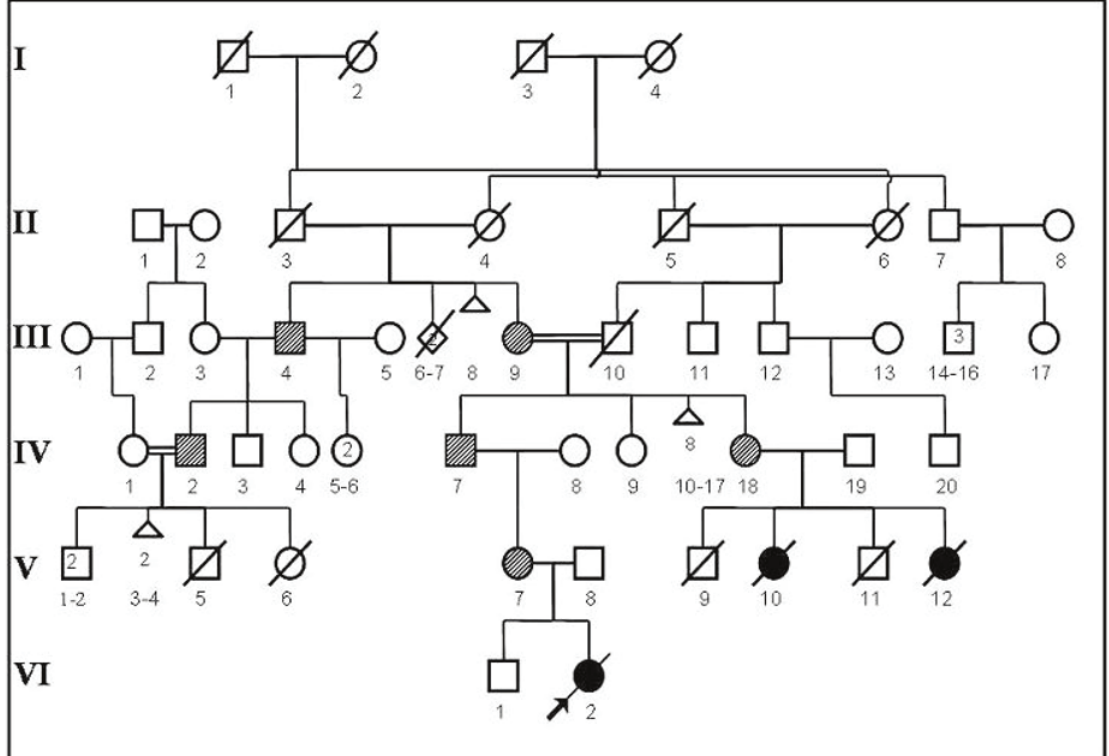
Figure 1. The pedigree of the family. Our proband is cousin with the other